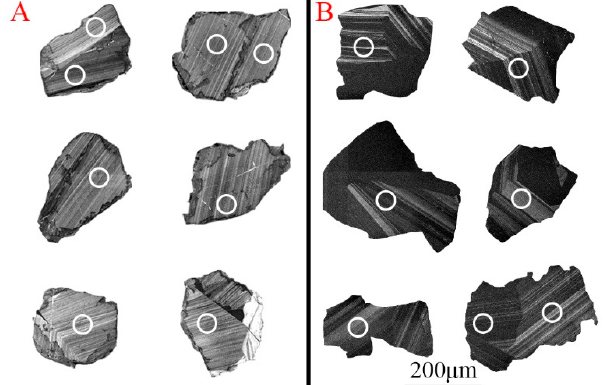
Figure 8. Representative cathodoluminescence images of cassiterite from the Maoping W–Sn deposit. The spot size of the laser beam is 50 μ m (white circles). ( A ) Sample Mp-5-11 from quartz vein ore. ( B ) Sample Mp-75-17 from greisen ore.